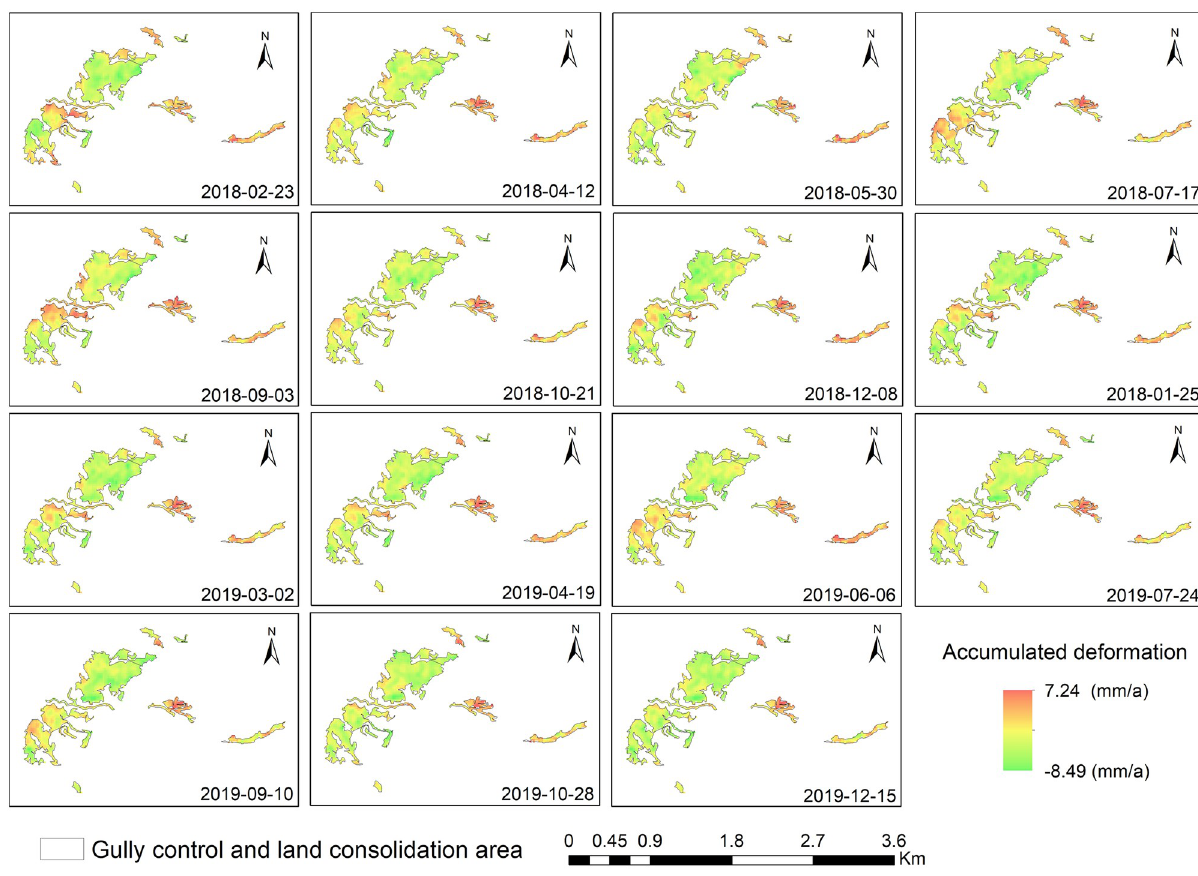
Fig 6. Time-series surface accumulated deformation in the target area in different periods. As can be observed from Fig 6, the accumulated deformation has increased with time and the influence scope continued to expand. Accumulated deformation rate was within -8.49 mm � a -1 to 7.24 mm � a -1 . No significantly higher subsidence or uplift is generated in the area. From April to August, accumulated deformation of gully control and land consolidation area was low, but from September to March of the next year, accumulated deformation was obvi- ously increased. That reflects that the infiltration of rainwater can lead to compacted loess deformation which caused by moistening effect. In terms of accumulated deformation spatial distribution, the accumulated deformation rate of the east part approach to maximum 7.24 mm � a -1 higher than west part approach to minimum -8.49 mm � a -1 . Additionally, accumulated deformation rate at edge was larger than that at the central part in the land consolidation area. The Mean Deformation Velocity of gully control and land consolidation area is shown in Fig 7. In the Fig 7, red color represents the negative value of deformation velocity, indicating that land subsidence which the ground object moves away from the satellite along the direction of radar sight; green color represents the positive value of deformation velocity, indicating that land uplift which ground object moves close to the satellite along the direction of radar sight. Land subsidence is the main deformation in land consolidation area, only a small part area is land uplift. The mean annual velocity of subsidence was from -6.19 mm � a -1 to 3.86 mm � a -1 .